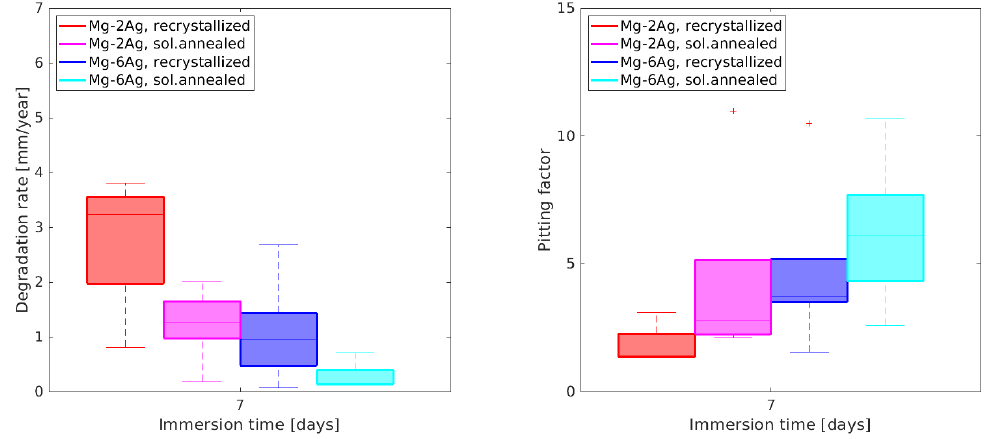
Figure A2. Degradation rate and pitting factor of the one recrystallized and solution annealed Mg- 2Ag and Mg-6Ag wire each after 7 days of immersion evaluated at three different heights displayed as boxplots. The boxplots show the median of the parameters as a line and the 25th and 75th percentiles. Outliers are plotted as